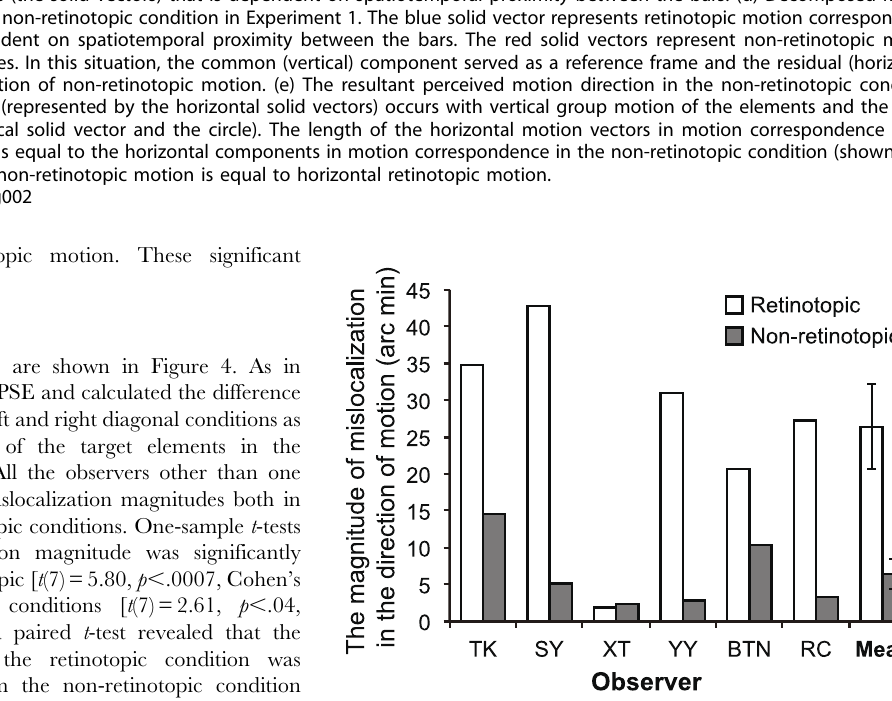
Figure 3. The results of the Experiment 1. Individual and mean data are shown. Error bars denote standard errors of the mean.